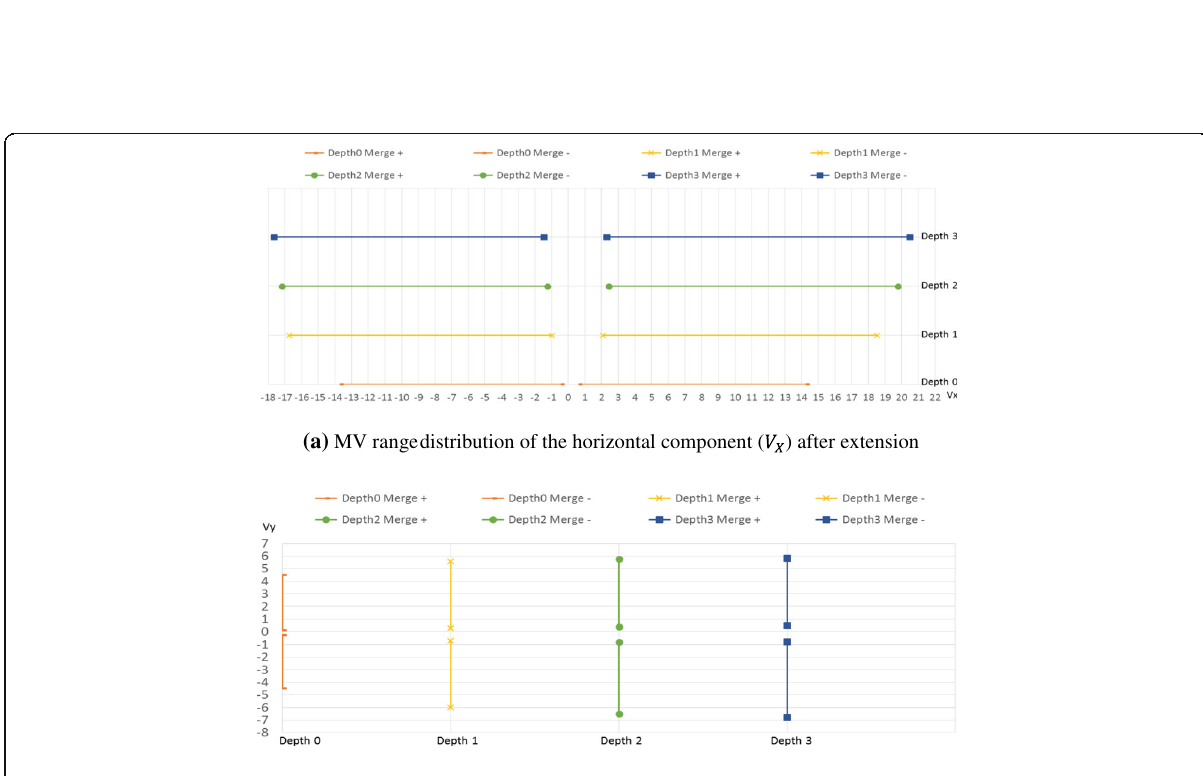
Fig. 13 MV range distribution of the ( a ) horizontal component ( V X ) and ( b ) vertical component V Y of the S03 sequence at QP22 after